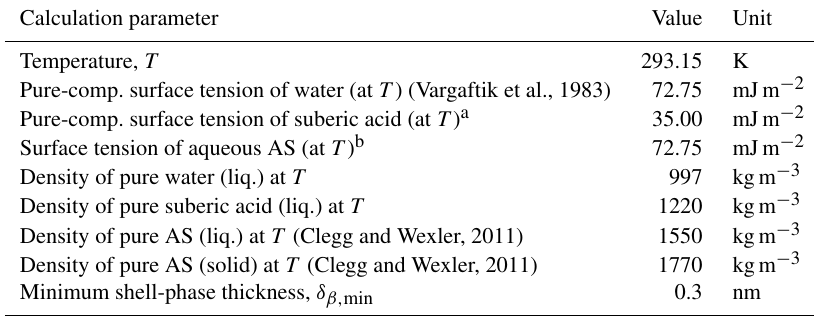
Table 1. Values of physical parameters used in AIOMFAC calculations. Density of mixtures were calculated as a linear (additive) combination of the apparent molar volumes of the contributions of water, ammonium sulfate (AS), and suberic acid.